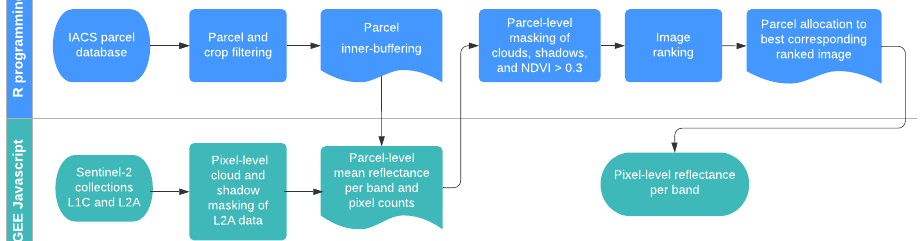
Figure 3. Overview of the major preprocessing steps to achieve high quality reflectance per pixel of parcels with potential bare soil.